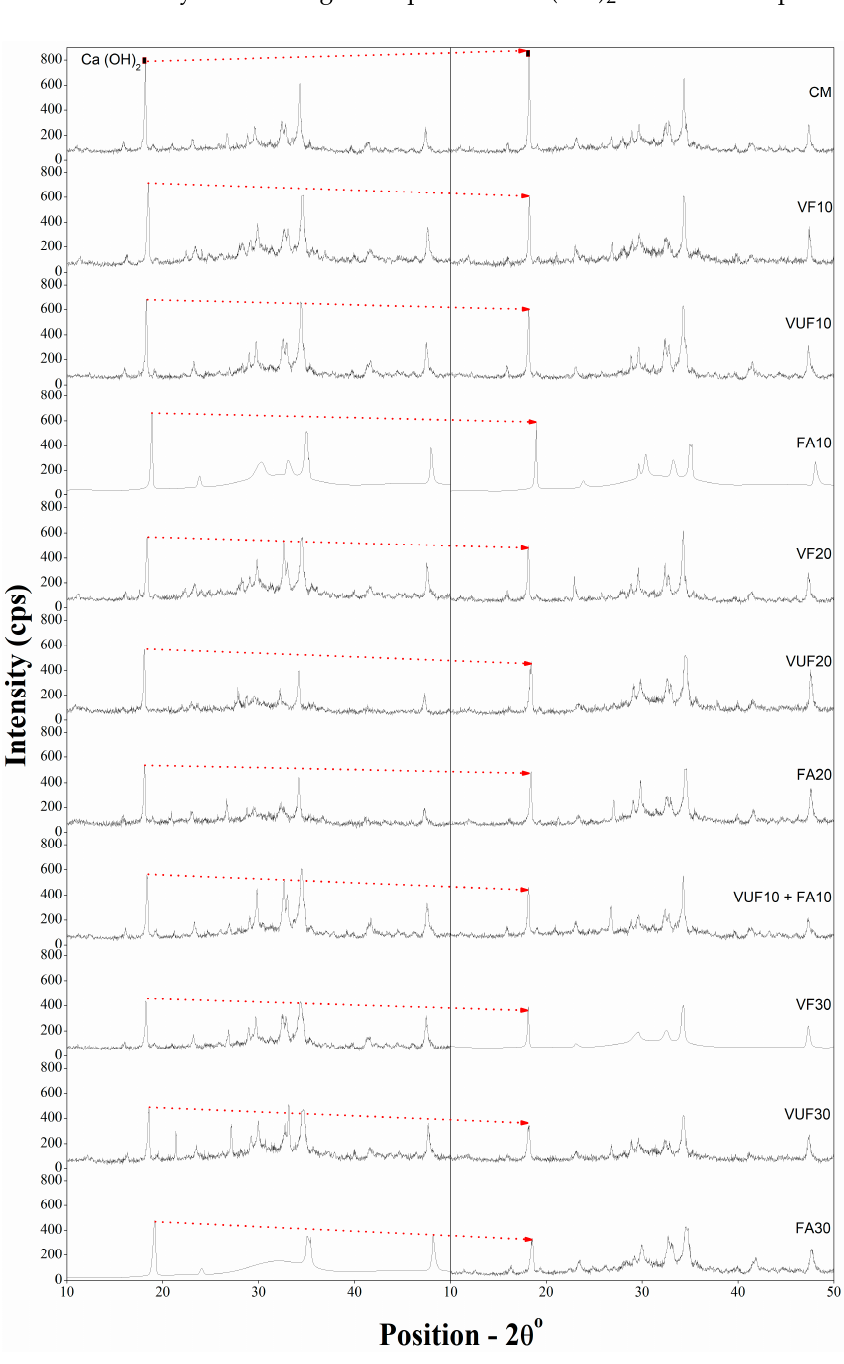
Figure 8. Comparison of XRD peaks between control paste (100% cement) and pastes containing di ff erent percentages of FA, VF and VUF at age of 7 and 91 days.